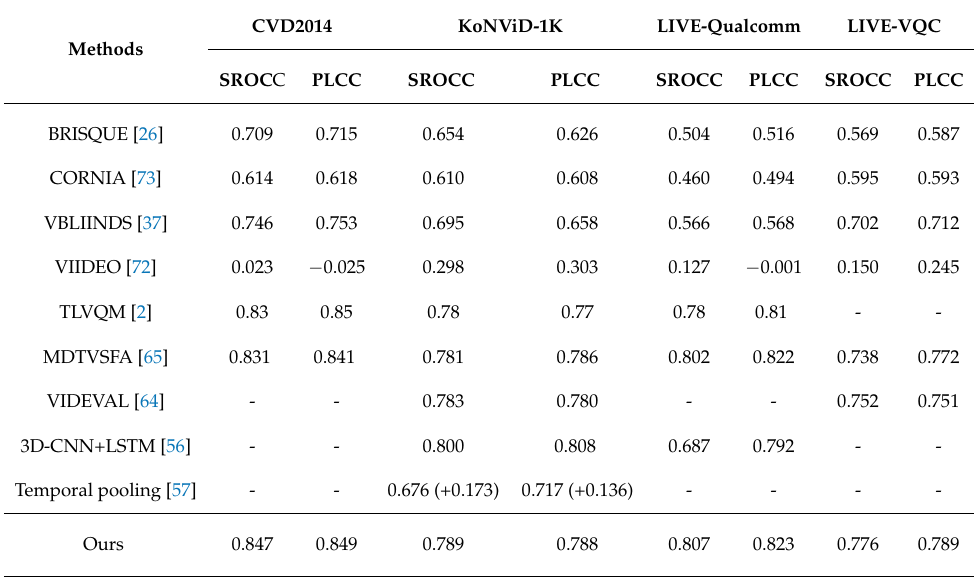
Table 5. Overall performance evaluation on four VQA databases. Results not reported are replaced with the “-”